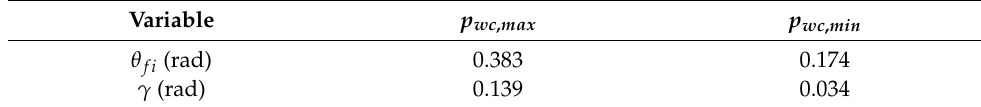
Table 3. Upper and lower bounds of walking condition variables p wc